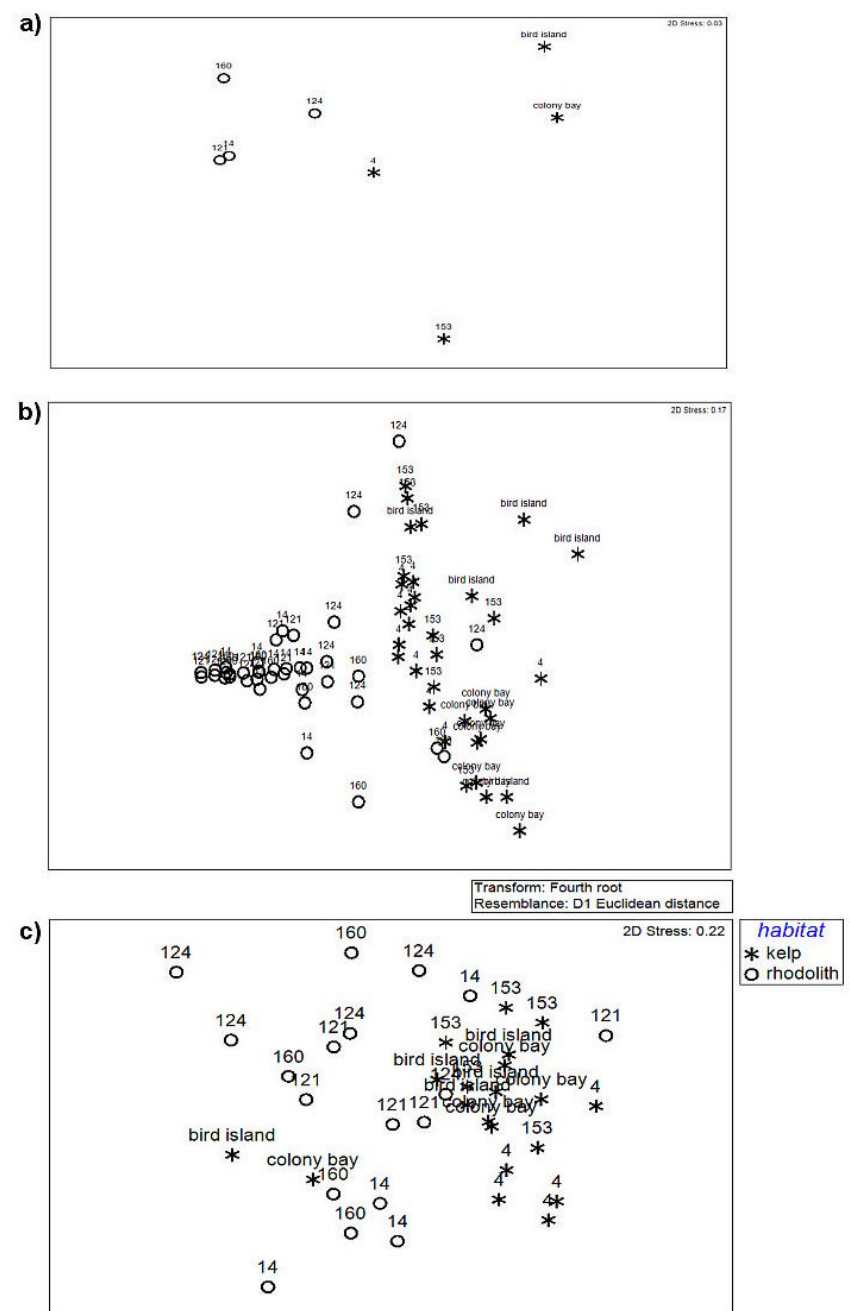
Figure 3. Faunal communities in kelp forest and rhodolith bed habitats are clustered using non-parametric multidimensional scaling (nMDS) plots with Euclidean distances for data from ( a ) swath surveys (n = 4 per habitat type) where rhodolith communities are more alike than kelp forests, ( b ) the benthic cover of marine communities (photo-quadrats, n = 5–10 depending on site), most similar within habitat type, and ( c ) the faunal communities of benthic grabs (n = 5 per site) which are distinct from each other, but show similarity within sites within habitats.